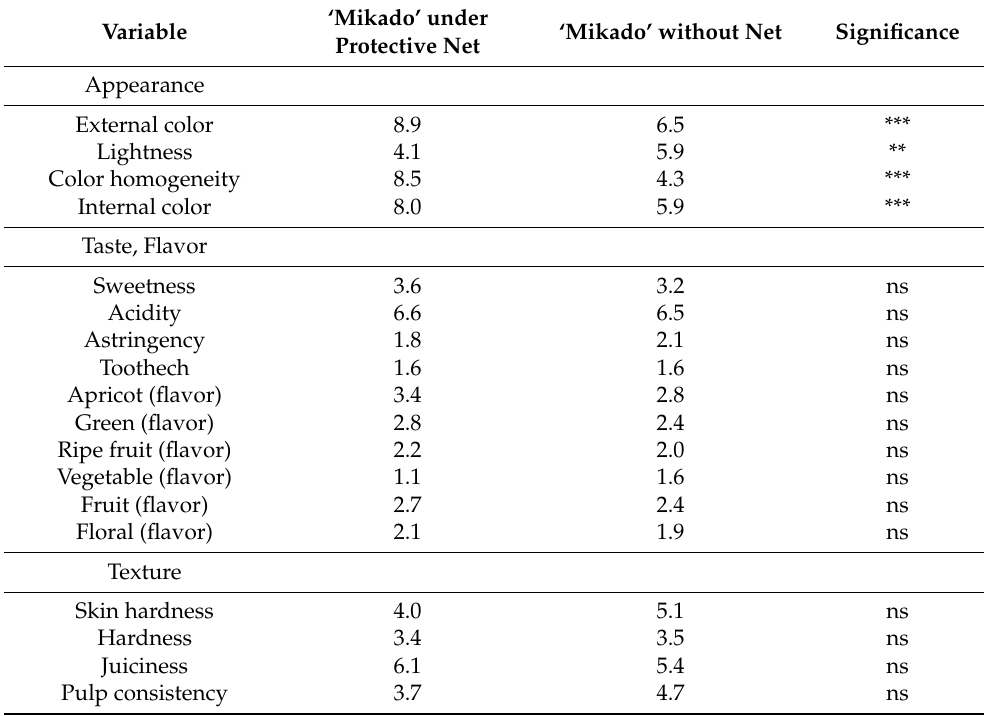
Table 4. Sensory evaluation. Mean values ( n =